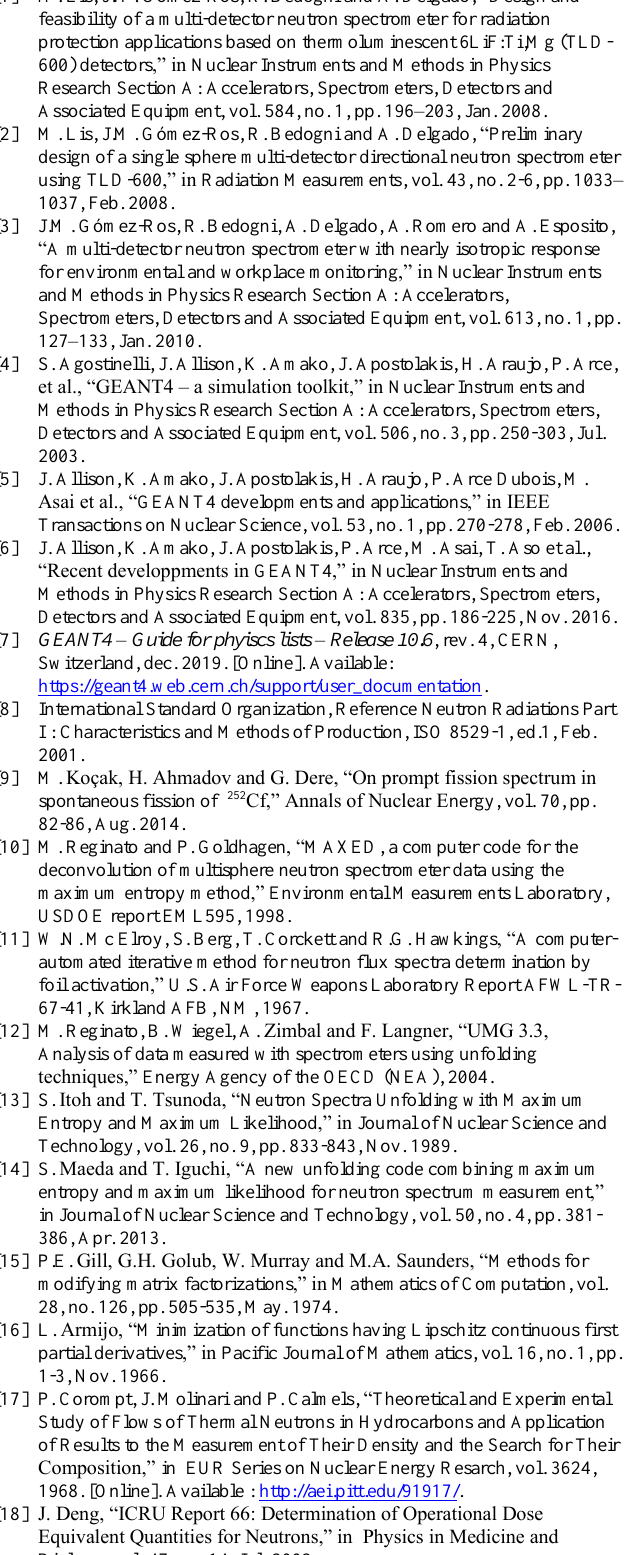
Section A: Accelerators, Spectrometers, Detectors and Associated Equipment, vol. 476, no. 1-2, pp. 12–20, Jan.